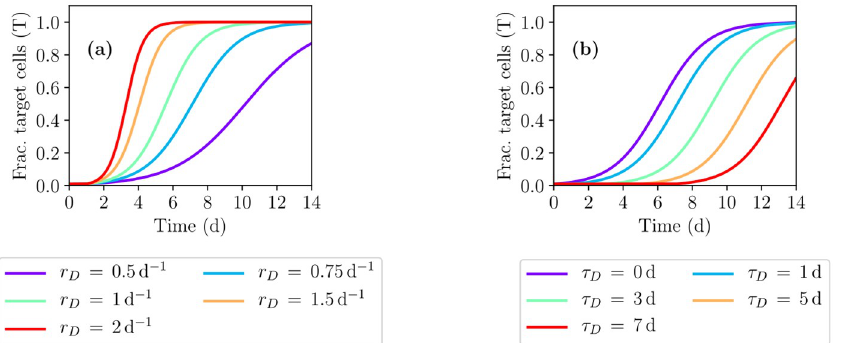
Fig 6. Target cell regeneration following a MM-simulated mechanical injury. Regeneration from mechanical injury was simulated using Eq (2) in the absence of infection, i.e. V ( x , t ) = E i ( x , t ) = I j ( x , t ) = 0 and D ( x , t ) = 1 − T ( x , t ). Initially, T ( x , t = 0) = 0.01, D ( x , t = 0) = 0.99, and D ( x , t < 0) = 0, representing an injury inflicted at t = 0 which removed 99% of all target cells. The effect of varying (a) the regeneration rate ( r D ) or (b) the regeneration delay ( τ D ) are shown. Unless varied, τ = 1 d and r = 0.75 d − 1 . D D